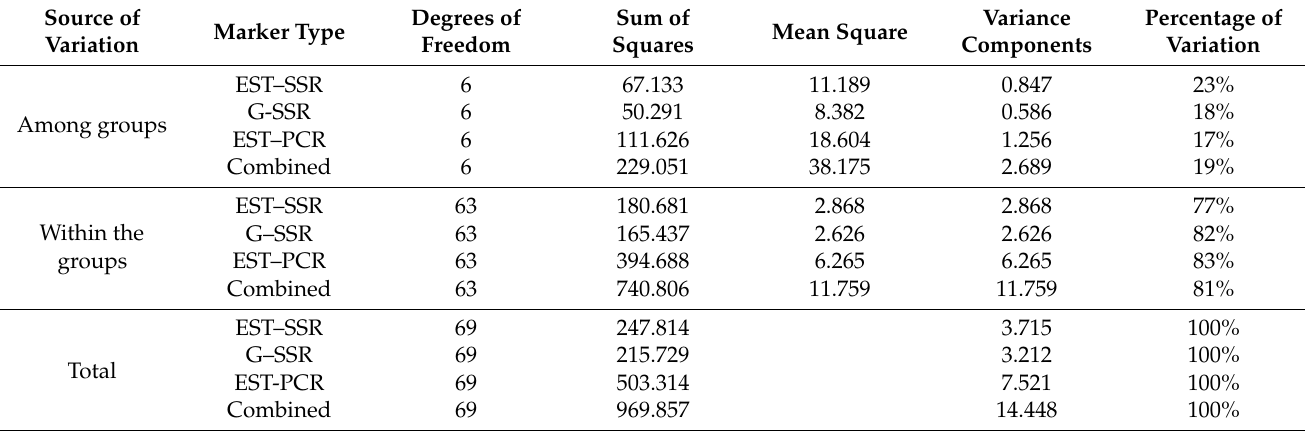
Table 6. Genetic differentiation among blueberry genotypes by analysis of molecular variance (AMOVA) based on seven groups, where four groups were comprised of wild clones collected from four Canadian provinces, the fifth group had all six cultivars, the sixth group contained 11 hybrids from the first cross (HB1–11), and the seventh group contained 17 hybrids from the second cross